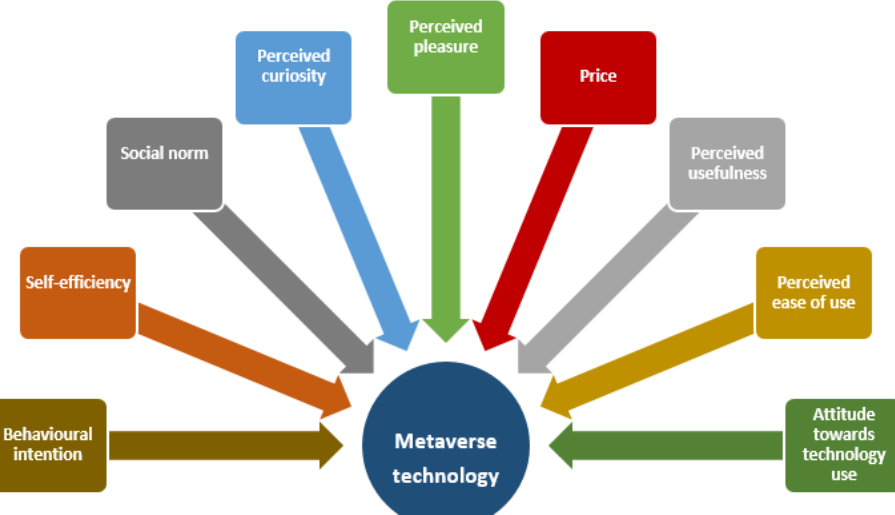
Figure 8. Variables affected the Metaverse technology and considered in this